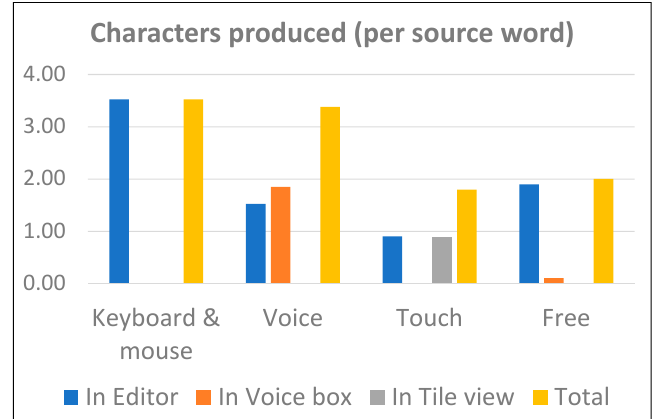
Figure 15. Number of characters produced in each of the interaction modes—2nd round of tests.